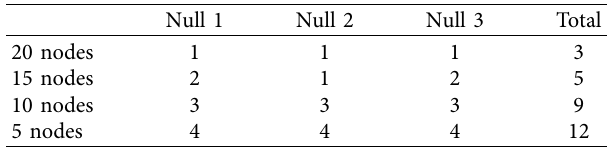
Table 12: Average power in the desired and all undesired directions corresponding to null steering using 20, 15, 10, and 5 nodes.